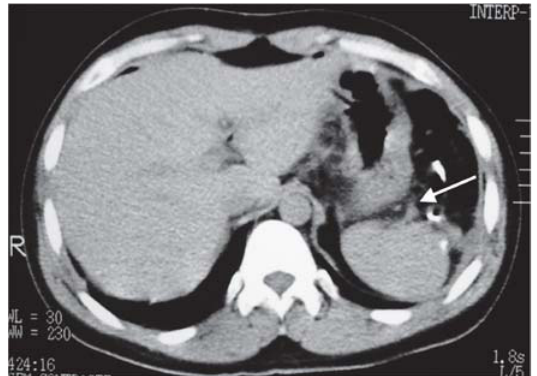
Figure 2 - Tomographic image of splenic remnant during the late postoperative periods following subtotal splenectomy for splenic ischemia. Observe the splenogastric vessels (arrow)